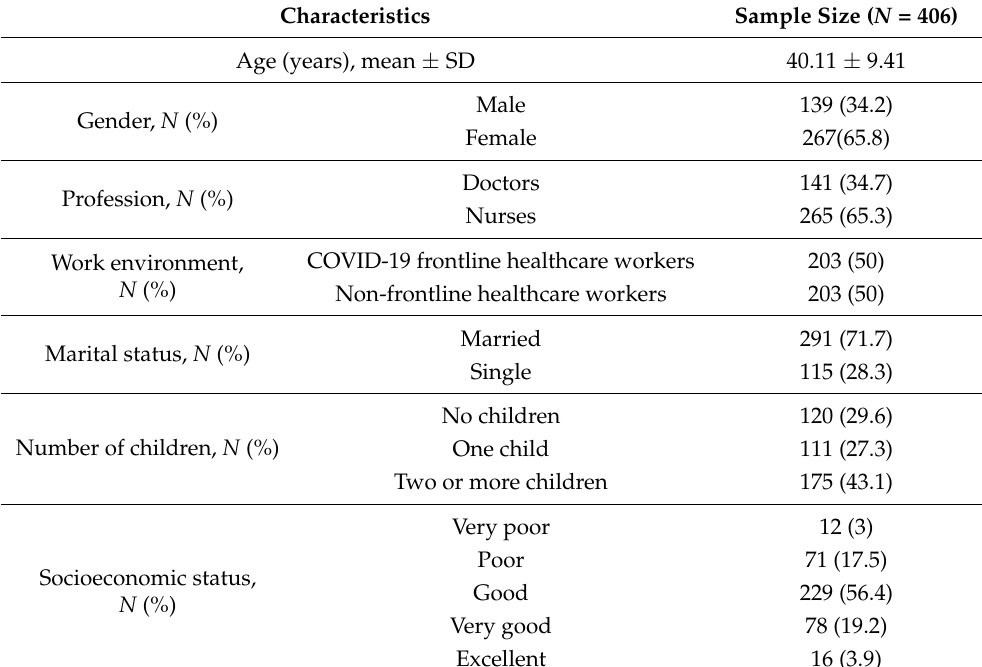
Table 1. Characteristics of the study participants.